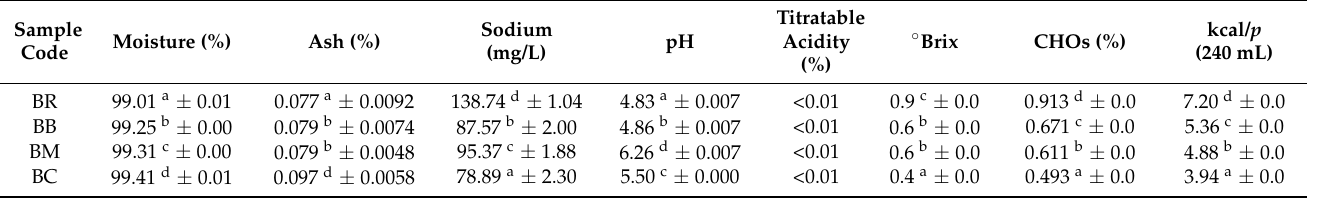
Table 2. Chemical characterization of the developed beverages.